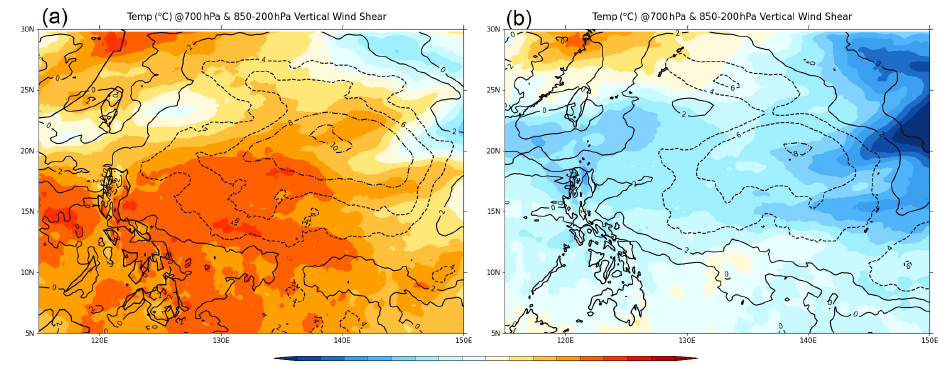
Figure 12. The difference of the simulated temperature (in degree Celsius) at 700hPa (shaded contours) and deep vertical wind shear (contour lines) averaged over the entire period of the simulation with (a) KF (corresponding to kfsnoffsf1) and (b) TK (corresponding to tksnoffsf1) temperature and winds from ERA5. The 6-hourly WRF output was interpolated to the coarser 6-hourly ERA5 grid using first- order conservative remapping through the CDO remapcon function. The CDO code is available at https://code.mpimet.mpg.de/projects/cdo/ (last access: 13 October 2021).